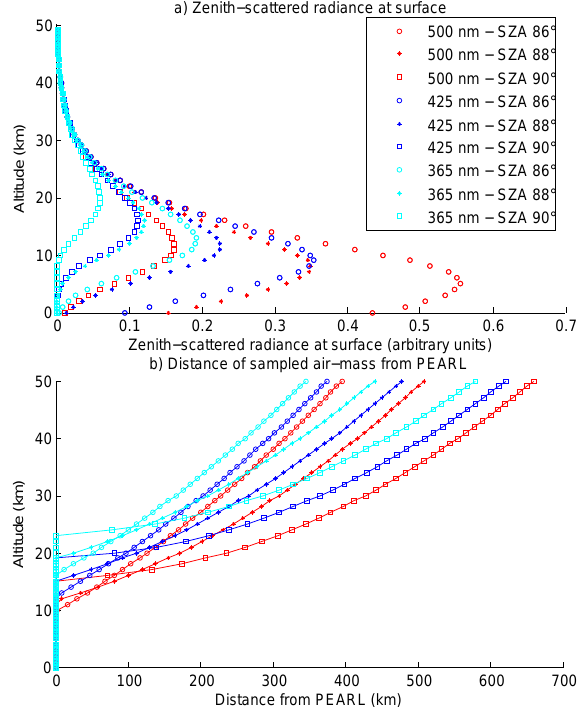
Fig. B1. (a) Zenith-scattered radiance at the surface and (b) hori- zontal distance of sampled air mass from the PEARL Ridge Lab as a function of the altitude of the sampled airmass for various SZA and wavelengths. Note that the horizontal distance of the sam- pled airmass was calculated with fixed scattering heights, given in Table